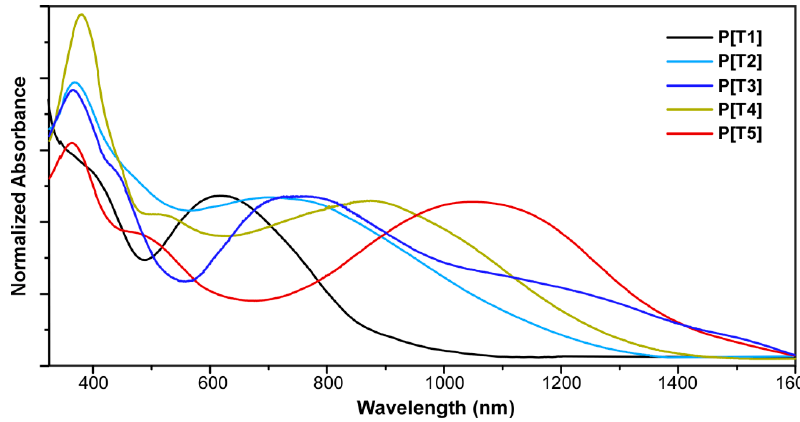
Figure 9. Thin film visible-NIR absorption spectra for polymers P[T1] – P[T5] . Table 4. Absorption data for polymer films of P[T1] – P[T5] .